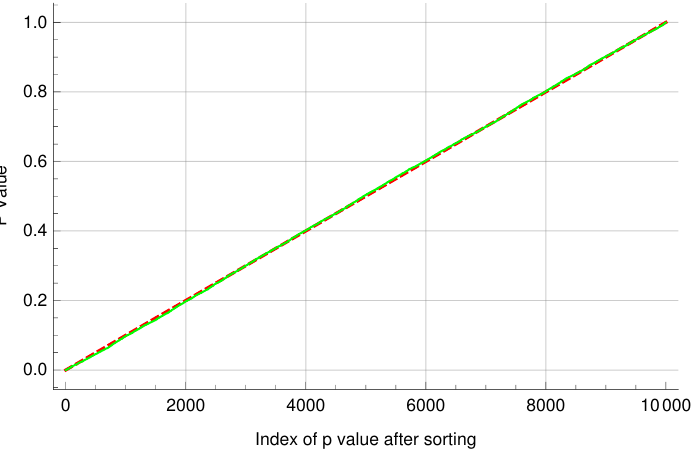
Figure 3. The p -values generated by performing likelihood ratio tests on 10,000 pairs of simulated fluctuation experiments. Because the two mutation rates were equal, the sorted p -values exhibited an expected linear pattern. The solid line represents the observed p -values, and the dashed line represents the theoretical reference lines with slope 10 − 4 and y -intercept 0.